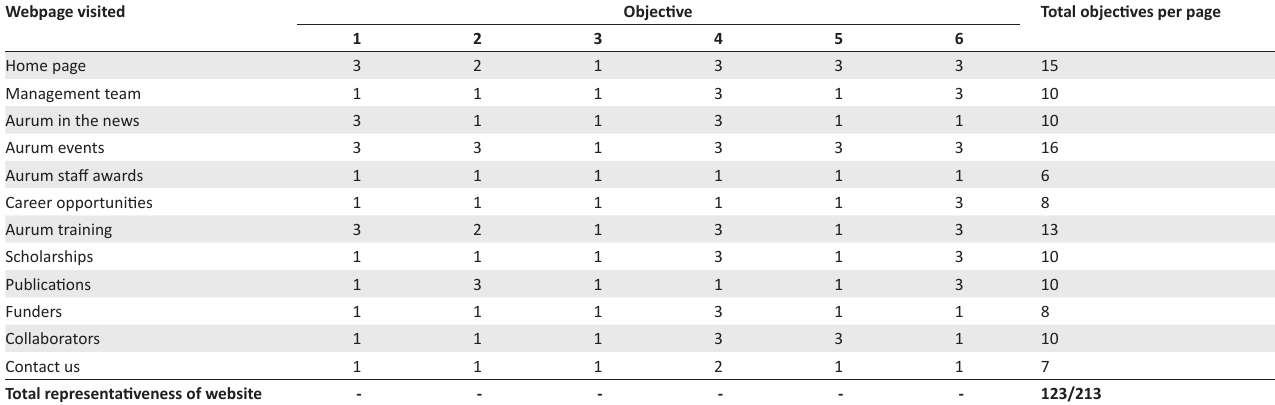
TABLE 1: Representation of organisational strategic objectives by each webpage. Webpage